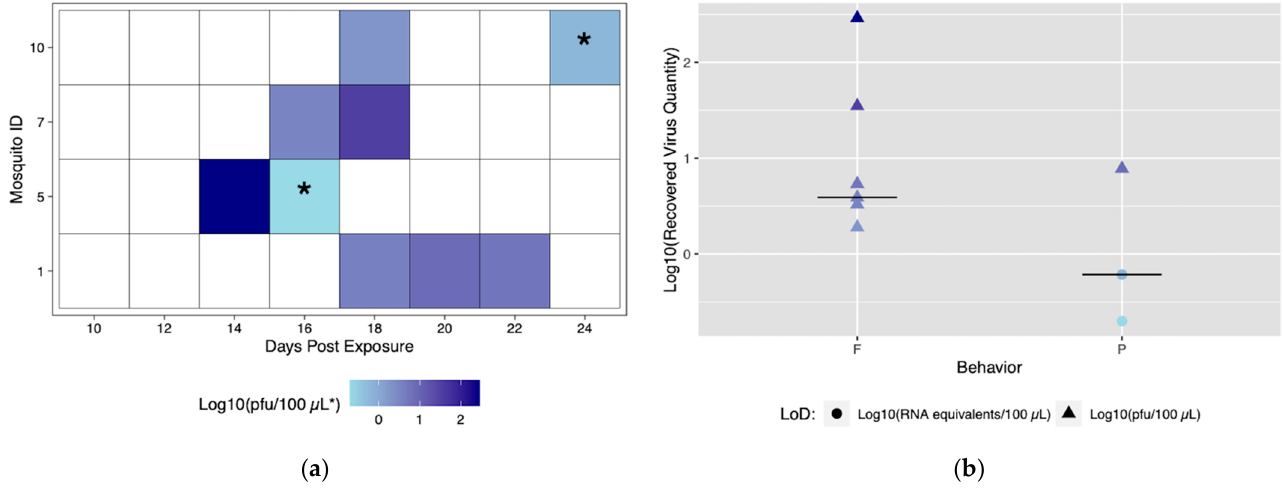
Figure 3. Viral titers expectorated with each successful transmission event by Rockefeller individuals. Only mosquitoes which had successful transmission over time are shown. A successful transmission event is defined by a positive serum sample via qRT-PCR and growth on Vero cells. ( a ) Each shaded square represents a transmission event, with white squares representing no detectable virus. Other squares are scored from lowest viral titer (light blue) to highest viral titer (navy). ( b ) Viral titers present in serum were compared for blood fed (F) vs. probed (P). Viral titers range from lowest detectable titer (light blue) to highest detectable titer (navy). Asterisks (*) indicate where recovered quantity is below the limit of detection from our sensitivity analysis and reflect qRT-PCR values of genome equivalents (viral RNA copies/100 μ L) rather than pfu/100 μ L.